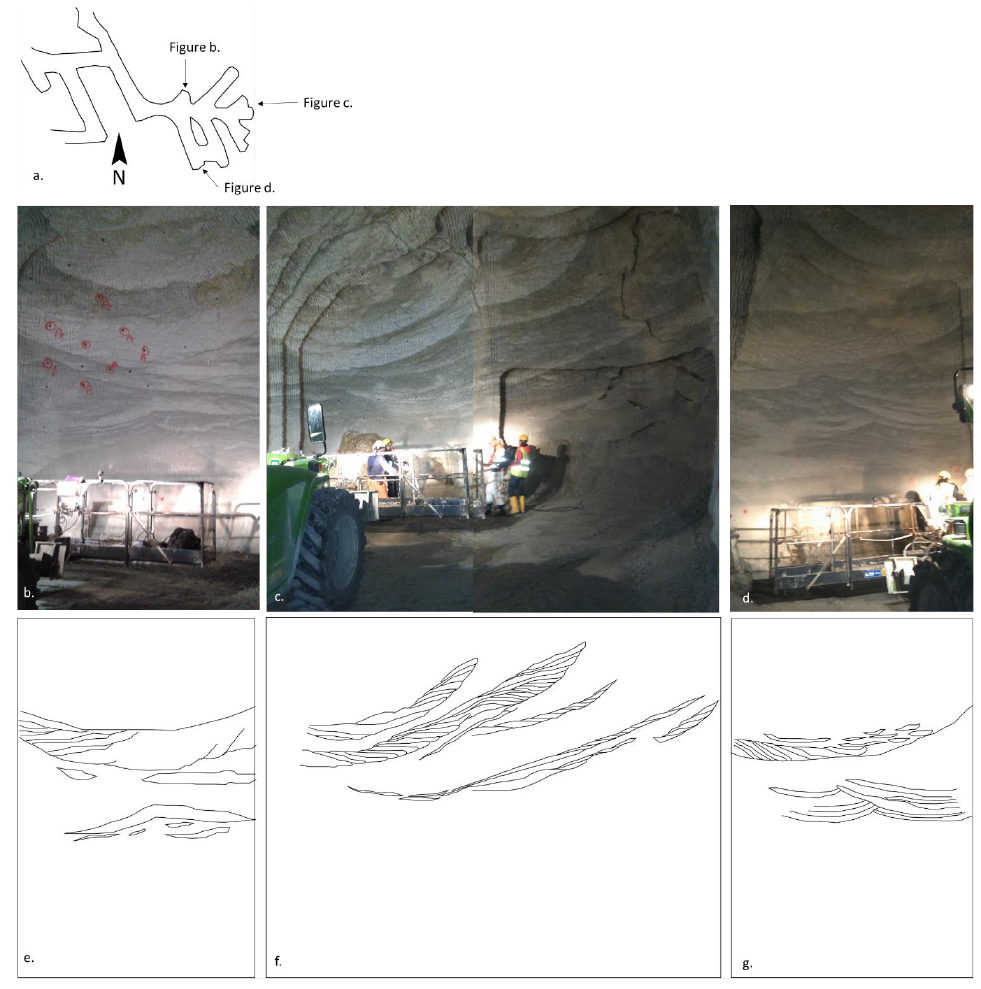
Figure 2. ( a ) Localization of the faces reported in this Figure in the schematized map of the under- ground tunnels of Calliano quarry. ( b – d ) Excavation faces in the Sturani Key Bed that expose the features of branching selenite gypsum. ( e – g ) Schematic representation of the main “branches” of gypsum identified in the excavation faces. At the sample scale, the rock appears to be organized in nodular aggregates com- posed of mm- to cm-sized gypsum crystals (Figure 3a – c). In the aggregates, the gypsum crystals are closely interlocked, creating a dense structure. Their habit is usually prismatic and several of the crystals present twinning (Figure 3d). Most of the crystals show the presence of inclusions, both fluid and solid inclusions (e.g., terrigenous grains and little gypsum crystals, as shown in Figure 3e).